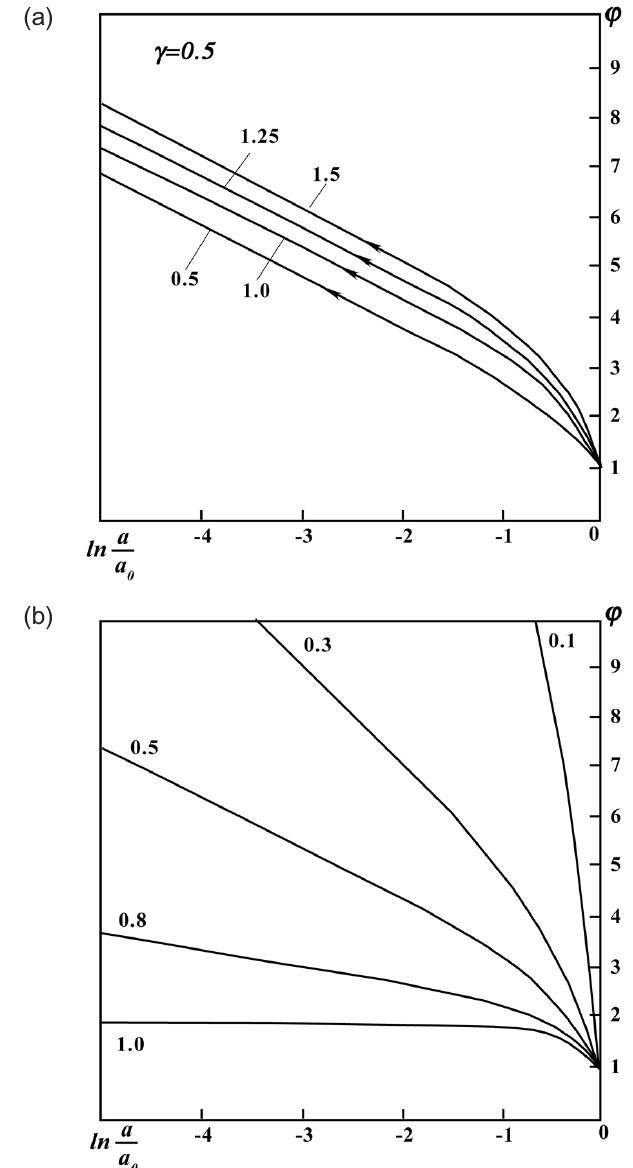
Fig. 3. The stream-lines of the nonlinear fractional oscillator (64) in the phase